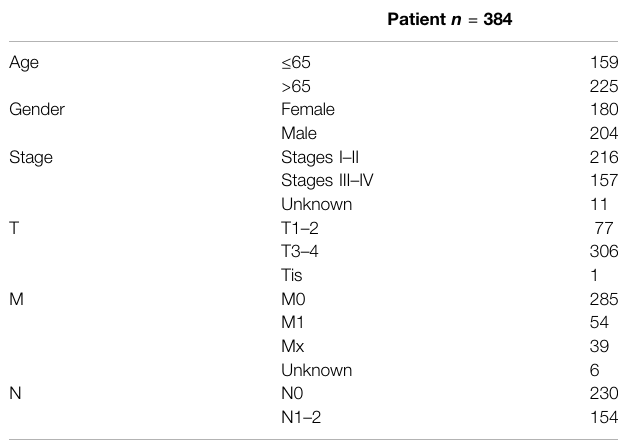
TABLE1| Theclinicalinformationofcolonadenocarcinoma(COAD)patientsfrom The Cancer Genome Atlas